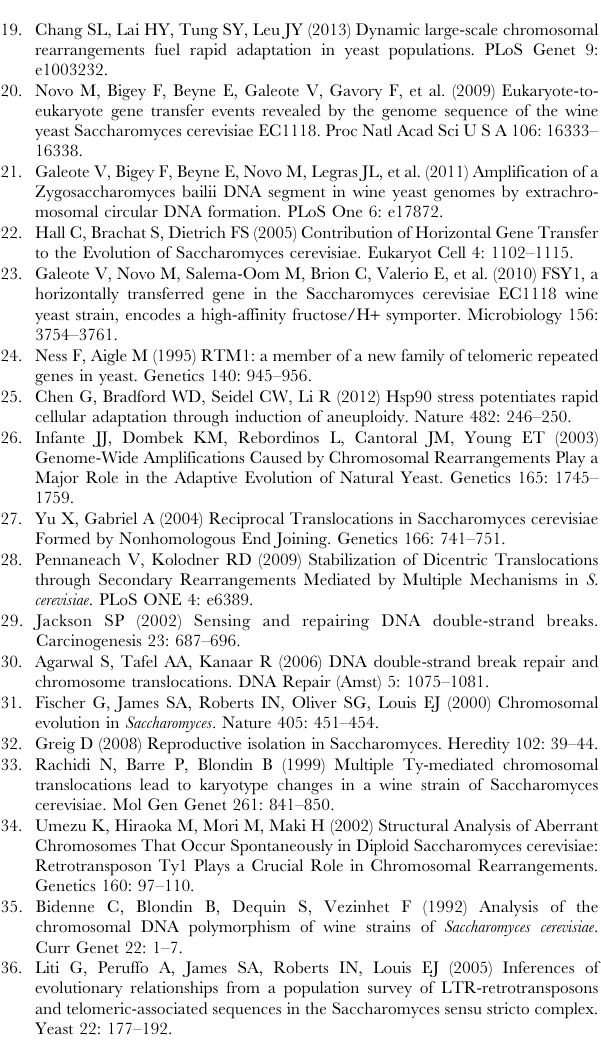
Table S3 a The SNPs and SAPs presented are given according to the reference genome (S288c strain) http://www.yeastgenome.